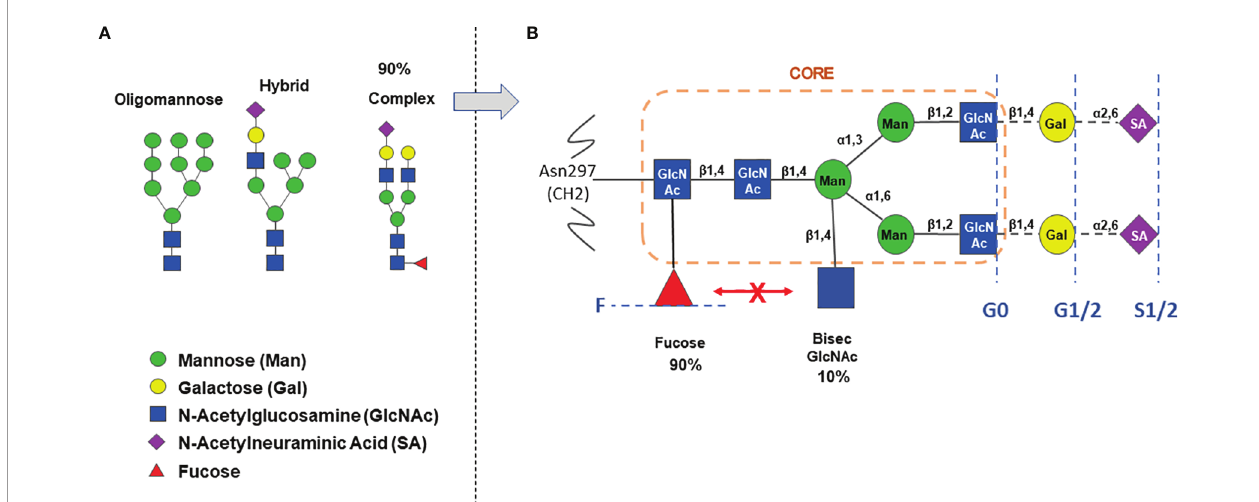
FIGURE 1 | The IgG Asn-297 N-glycan heterogeneity. Panel (A) major types of N-glycosylation observed in IgG. Panel (B) detail of complex type glycosylation with percentage of circulating IgG containing either fucose or bisecting N-Acetylglucosamine. The orange circle indicates the core structure. The blue broken lines and text indicate the heterogeneity of complex N-glycans, carrying either no Gal (G0), 1-2 Gal (G1/2), 1-2 Sialic acids (S1/2), with (F) or without core a